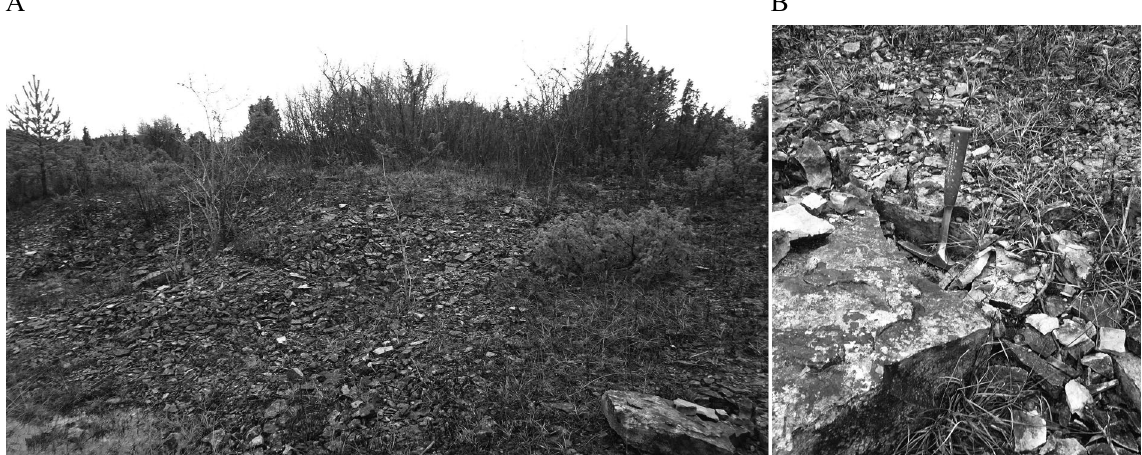
Fig. 1. A view of the Pähkla Quarry ( A ) and the available outcrop section ( B , a detail of the lower right corner of figure